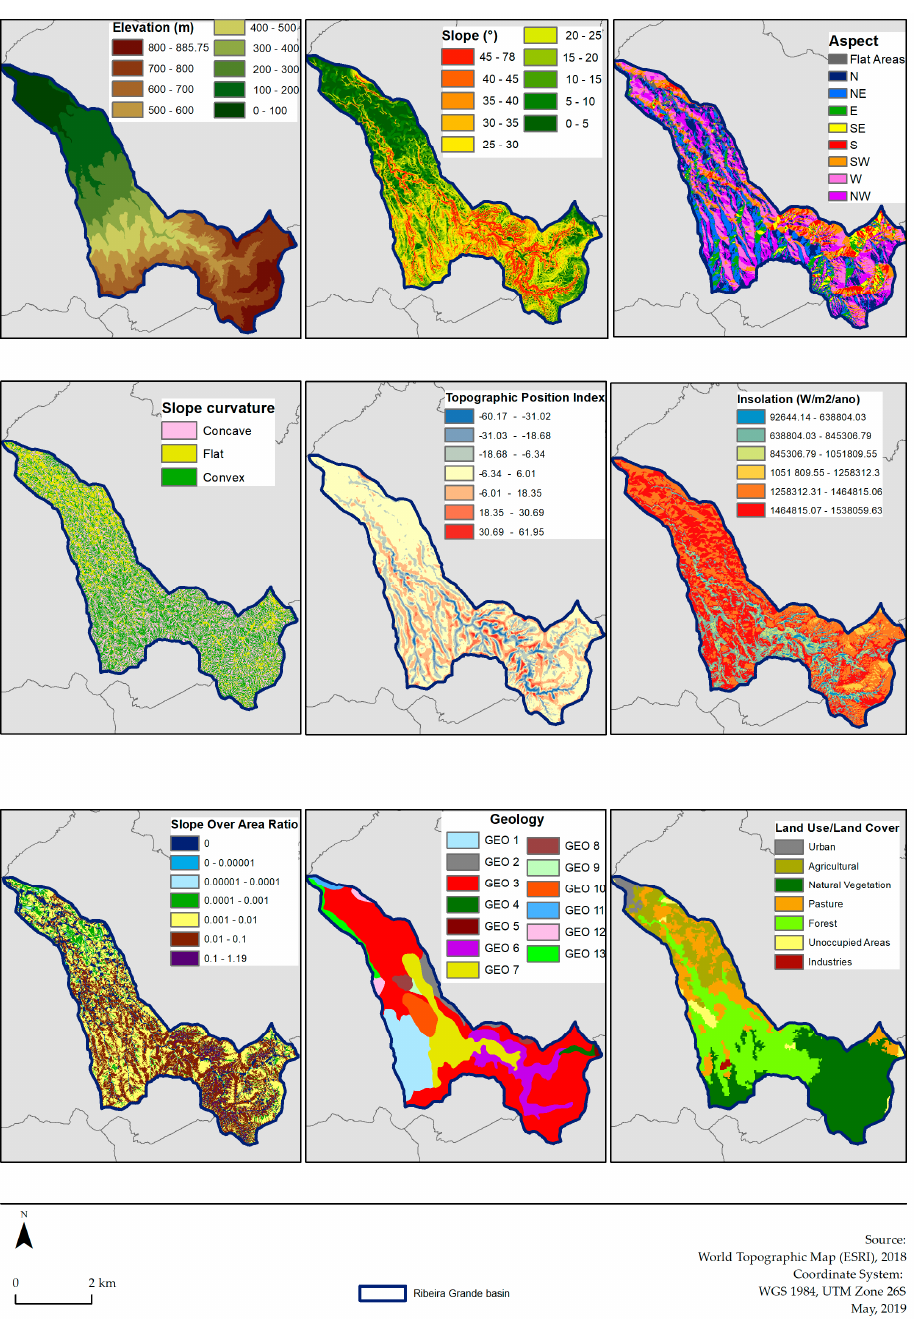
Figure 5. Predisposing factors used in susceptibility models. Geology classes codes are described in